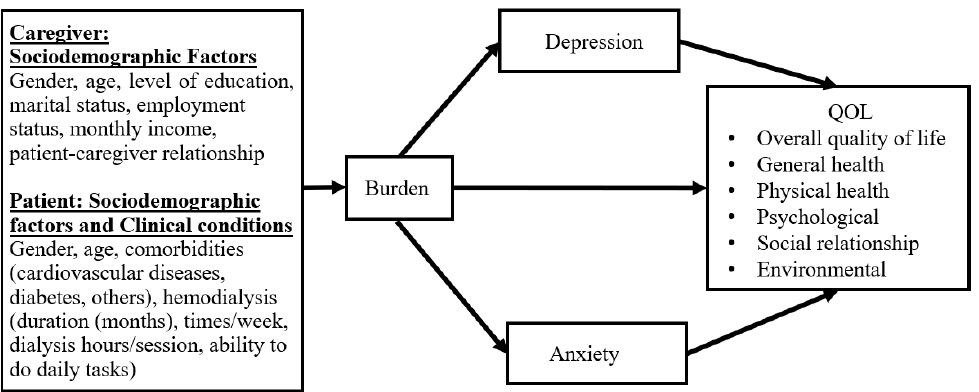
Figure 1. Conceptual framework of the association of sociodemographic and burden in this